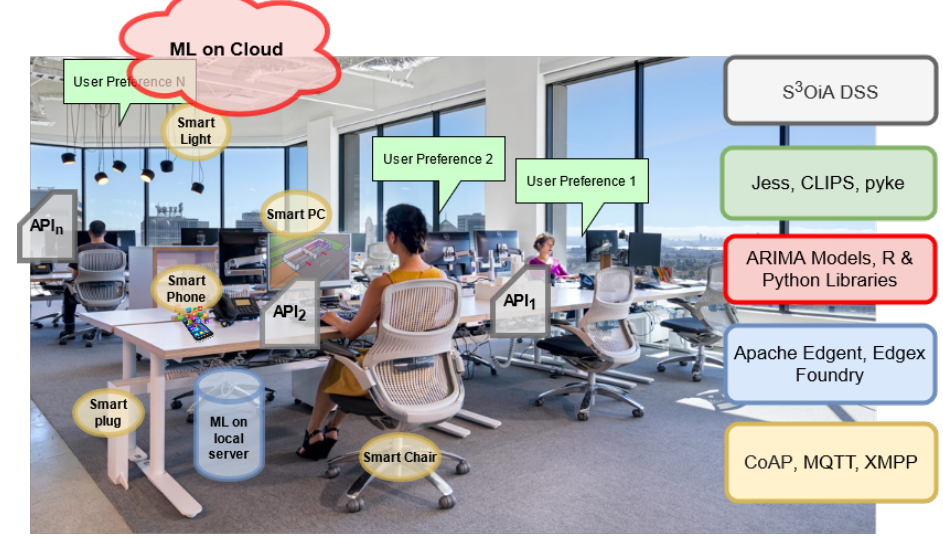
Figure 7. Implementation of the PyFF architecture in a smart